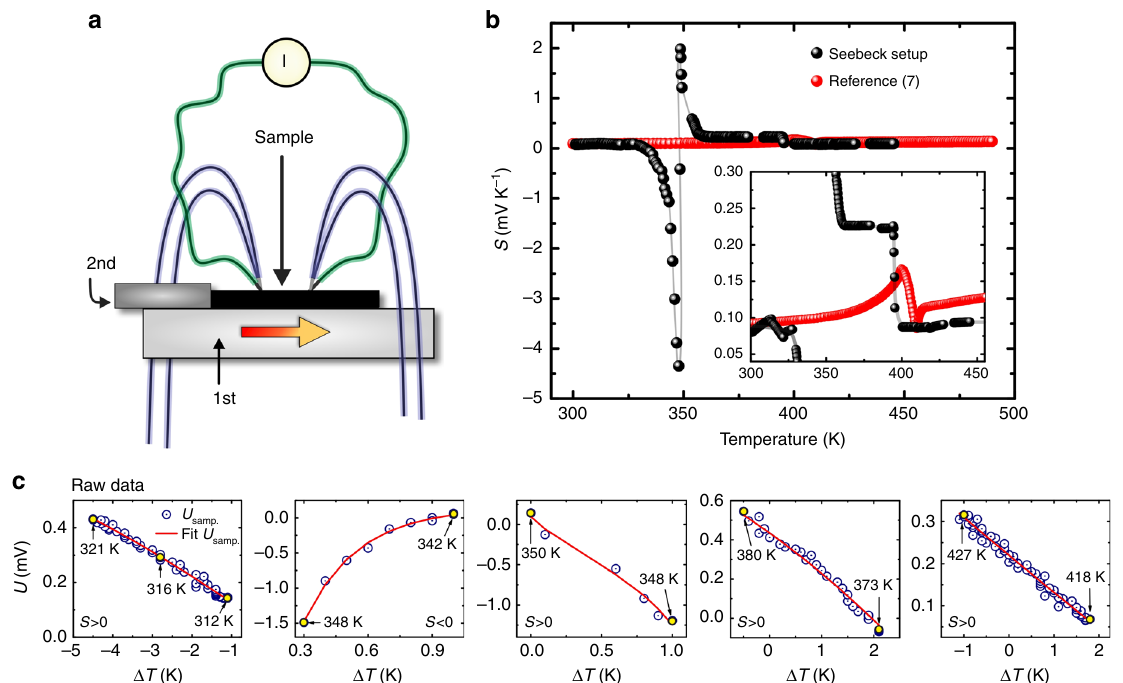
Fig. 2 Seebeck coef fi cient of Cu 2 Se. a Schematic drawing of the Seebeck experimental setup. b Seebeck coef fi cient results with its zoom in the inset, and reference data 7 . c Raw data of the thermal electromotive force as obtained by the